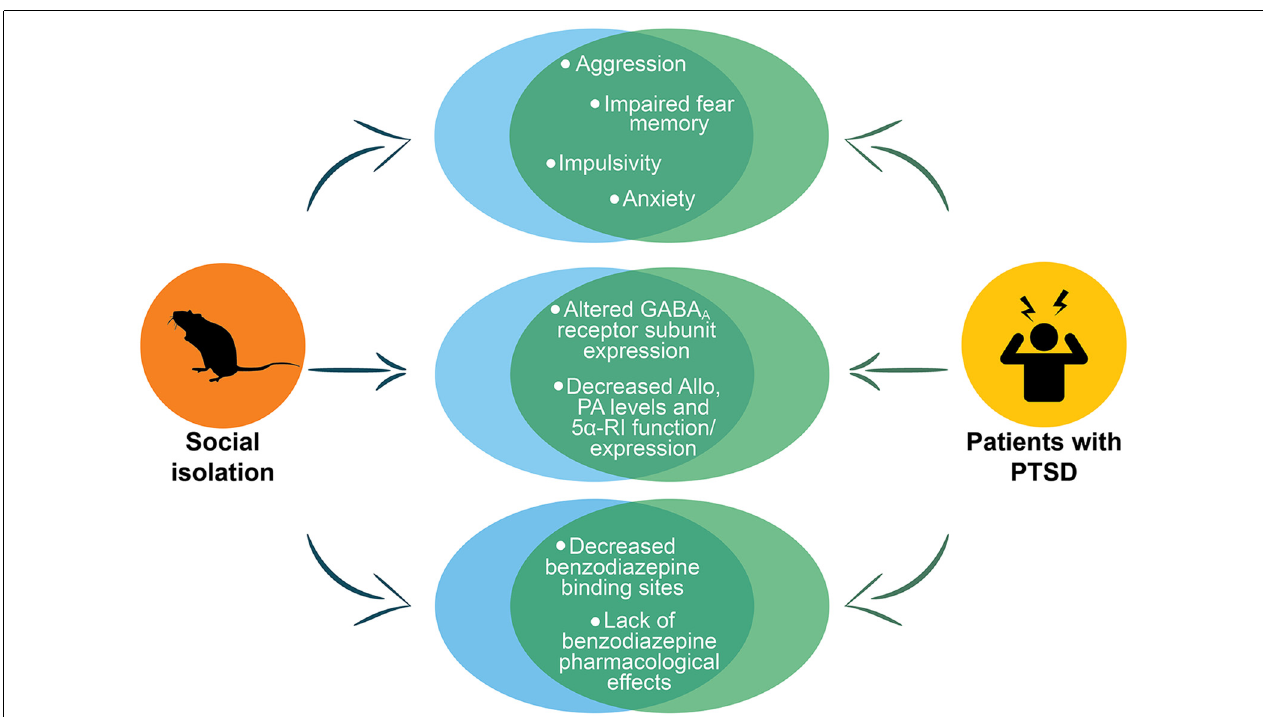
FIGURE 4 | Representation of the main PTSD phenotypes in socially isolated mice. The figure shows the phenotypes in socially isolated mice that recapitulate to deficits in PTSD patients. The circles at the top of the figure show the behavioral phenotype of socially isolated mice that includes aggression, impaired fear memory, impulsivity and anxiety, which are all core behavioral symptoms of PTSD. In the center of the figure are reported the abnormalities in GABA A receptors and neurosteroid levels. The last circles at the bottom report the altered pharmacological response to benzodiazepines that has been reported both in socially isolated mice and in humans with PTSD. Allo, allopregnanolone; PA, pregnanolone; 5 α -RI, 5 α -reductase type